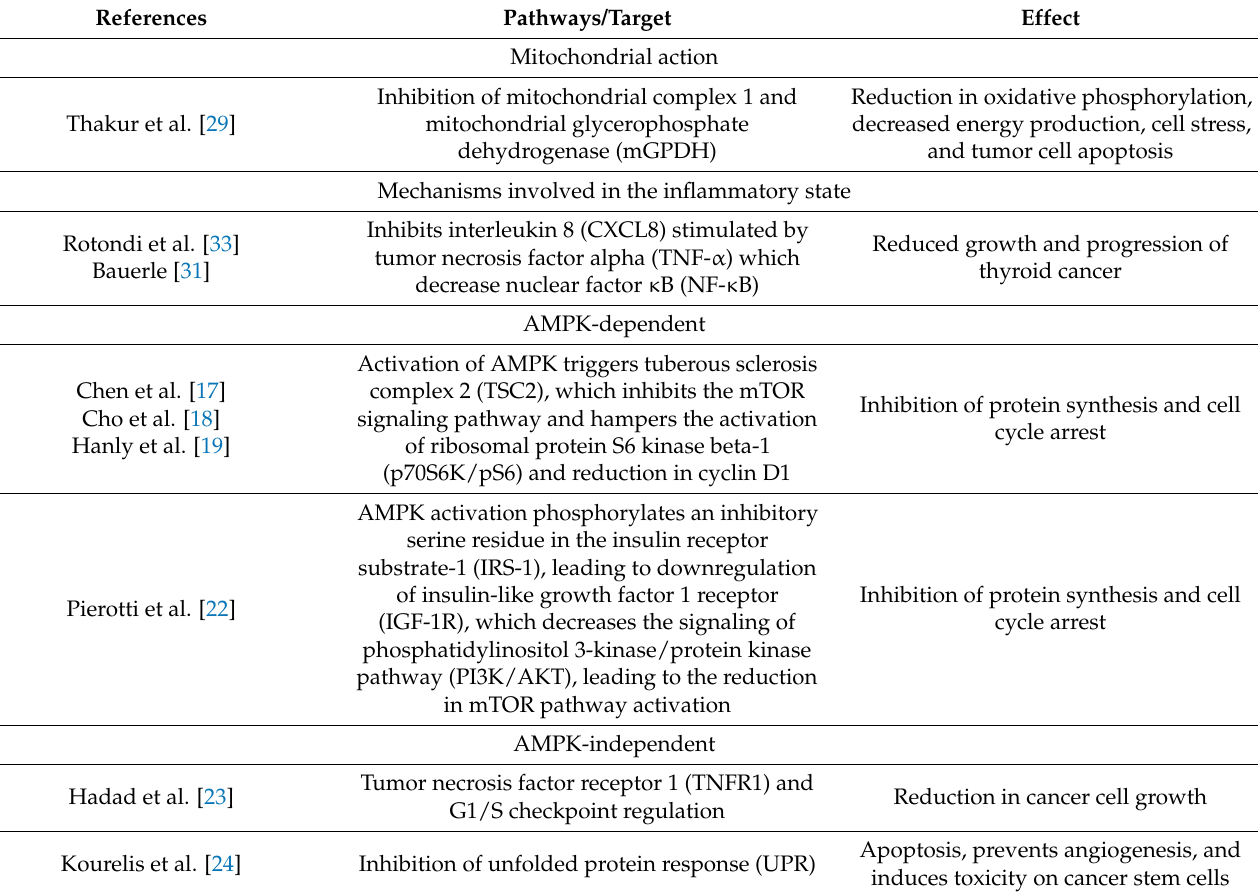
Table 1. Metformin pathways/targets identified by in vitro